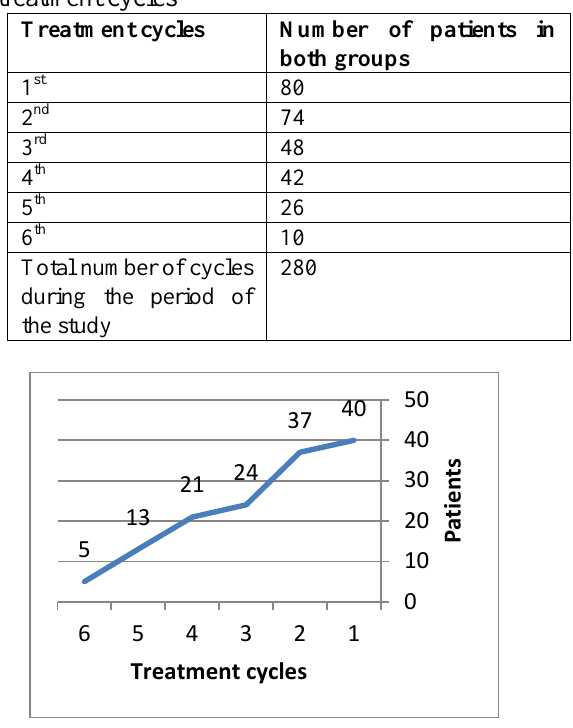
Table-2: Number of patients included in both